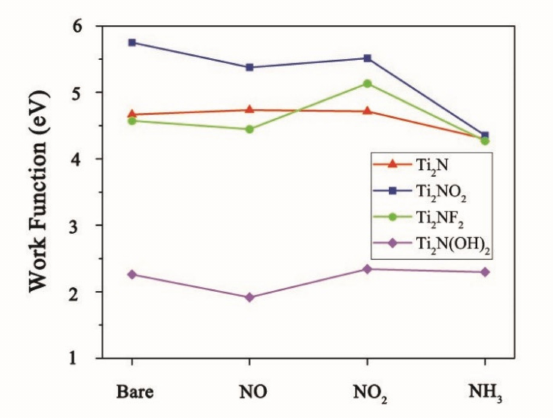
Figure 7. Work function change of Ti 2 N and Ti 2 NT 2 (T=O, F, OH) before and after adsorption of various